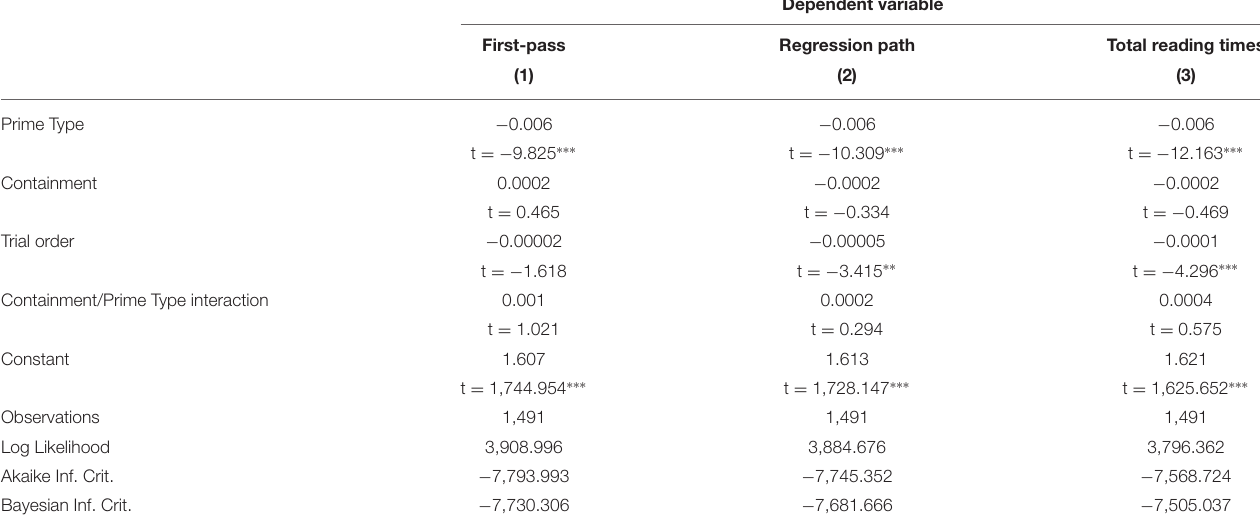
TABLE 8 | Regression analysis of reading times in the NOUN region of Experiment